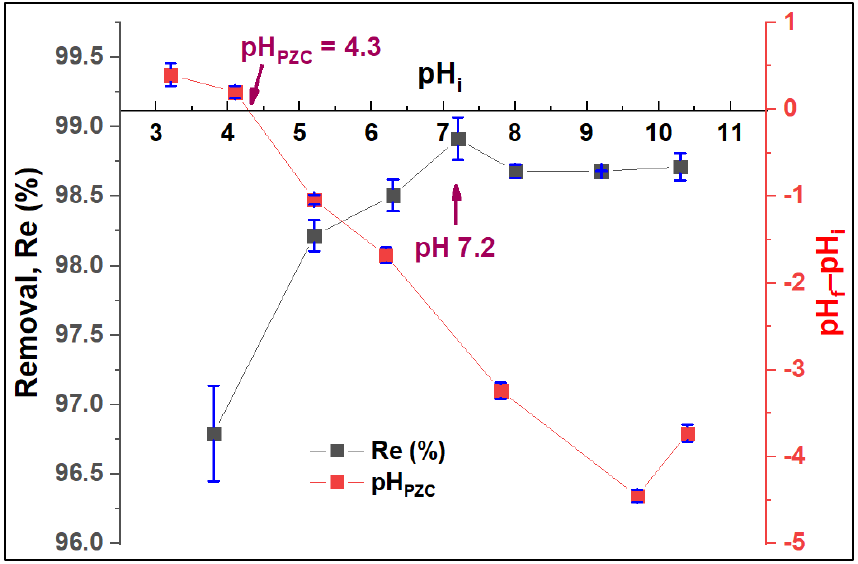
Figure 9. Effect of pH on the adsorption process of CV by ZFAC and the pH at surface zero charge (pH PZC ) of ZFAC adsorbent. Bars represent the standard error of the mean ( n = 2).